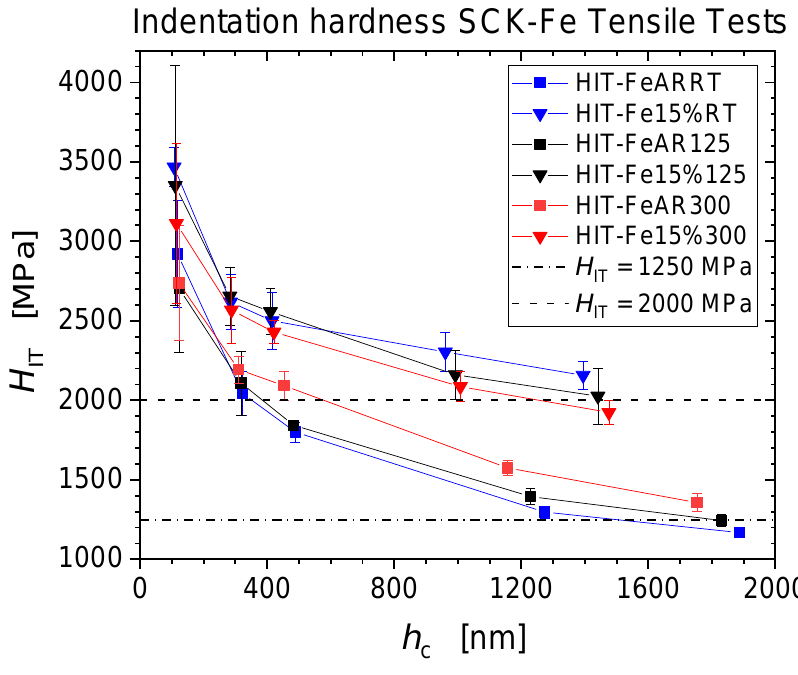
Figure 3. Depth dependence of hardness of un-strained and 15% pre-strained Fe from nanoindenta- tion measurements.